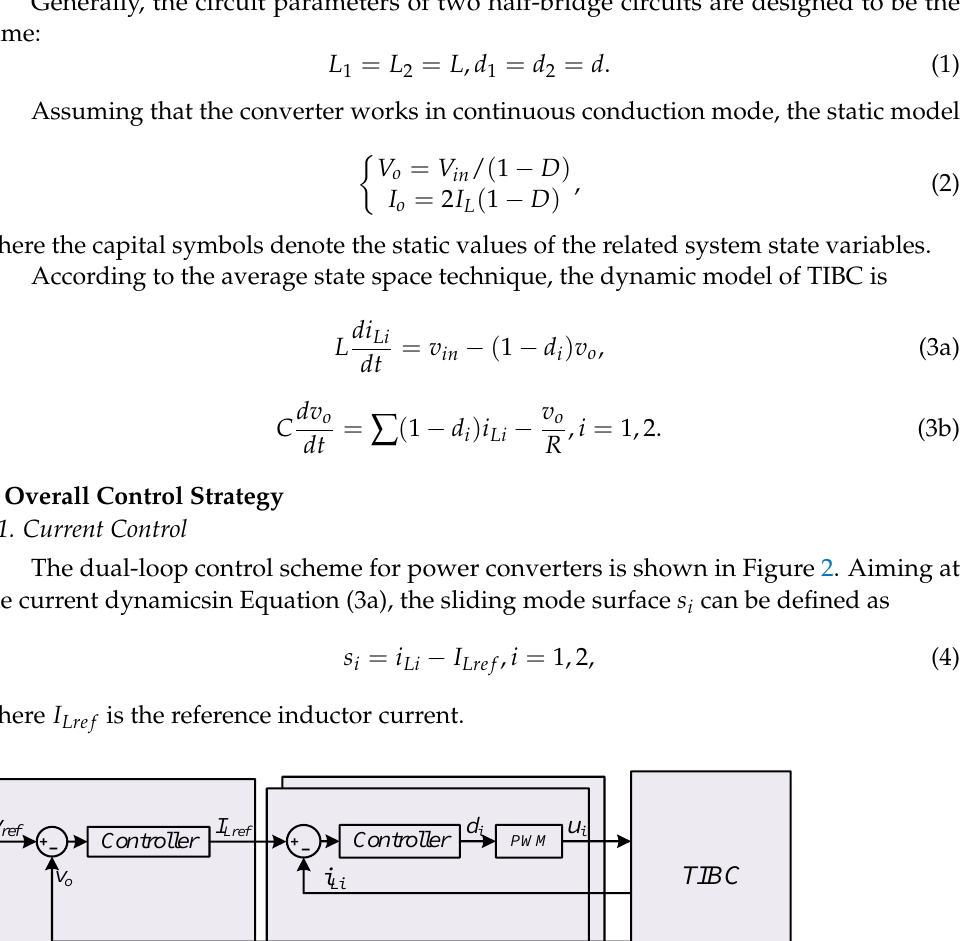
Figure 2. The cascaded dual-loop control structure.